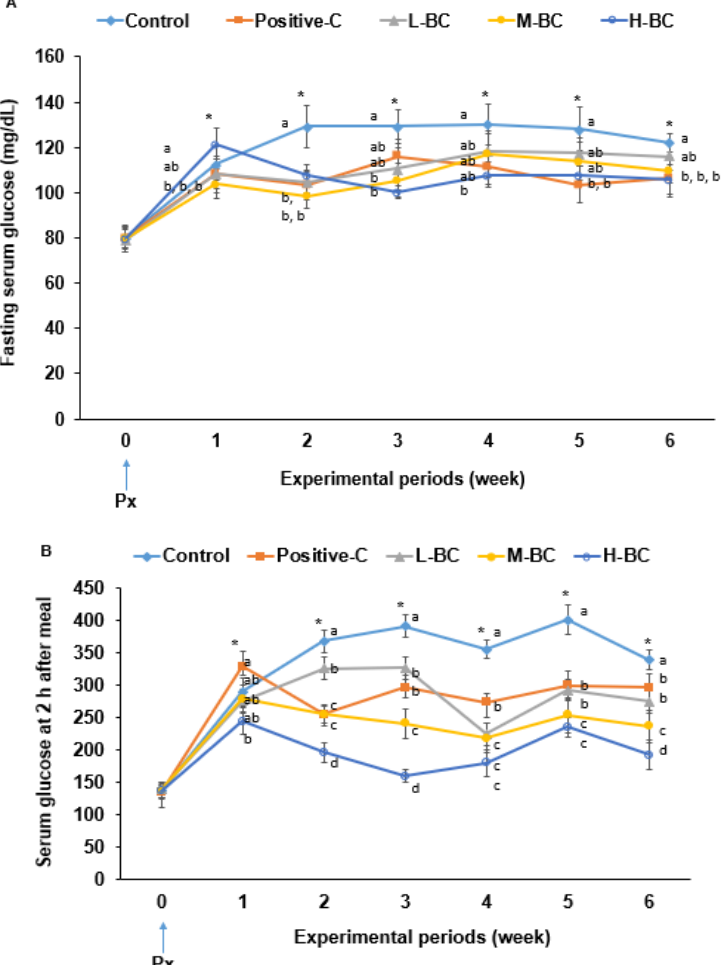
Figure 1. Changes of serum glucose concentrations after fasting and at 2 h post-ingestion over the eight-week experimental period. Partially pancreatectomized (Px) rats were fed a high-fat diet supplemented with 0% (control), 0.2% (L-BC; low dosage), 0.6% (M-BC; medium dosage), and 1.8% (H-BC; high dosage) blackcurrant extracts; 0.2% metformin (positive-C); plus 1.8%, 1.6%, 1.2%, 0%, and 1.6% indigestible dextrin over eight weeks. ( A ) Serum glucose concentrations in the fasted state each week. ( B ) Serum glucose concentrations in the 2 h postprandial state each week. Each dot and error bar represents a mean and standard deviation, respectively ( n = 10). * Significantly different among the groups in each week at p < 0.05.